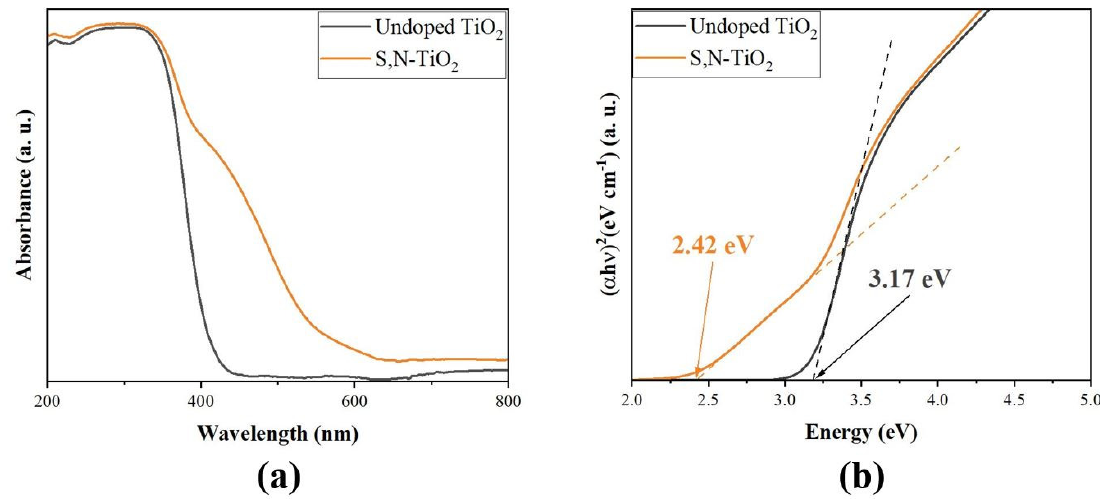
Figure 8. ( a ) UV-Vis spectra and ( b ) Tauc plot of undoped TiO 2 and S,N-doped TiO 2 photocatalyst powders.